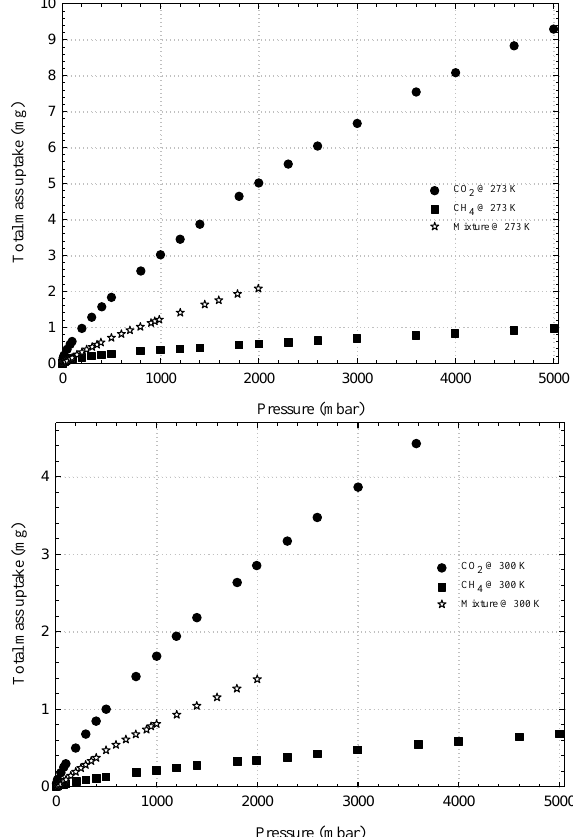
Figure 9. Adsorption isotherms of methane, carbon dioxide and their mixture in SWCN at 273 and 300 K.